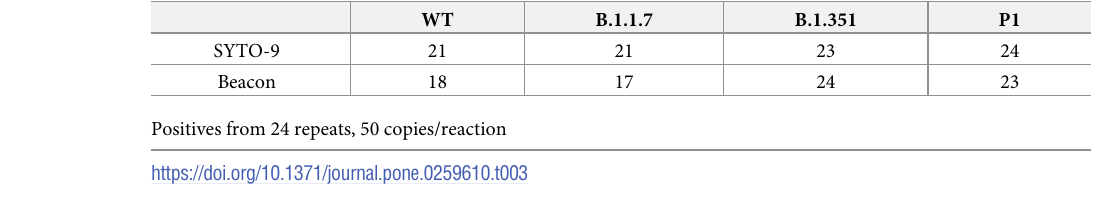
Table 3. Specific detection of variant RNA with LAMP and molecular beacons.